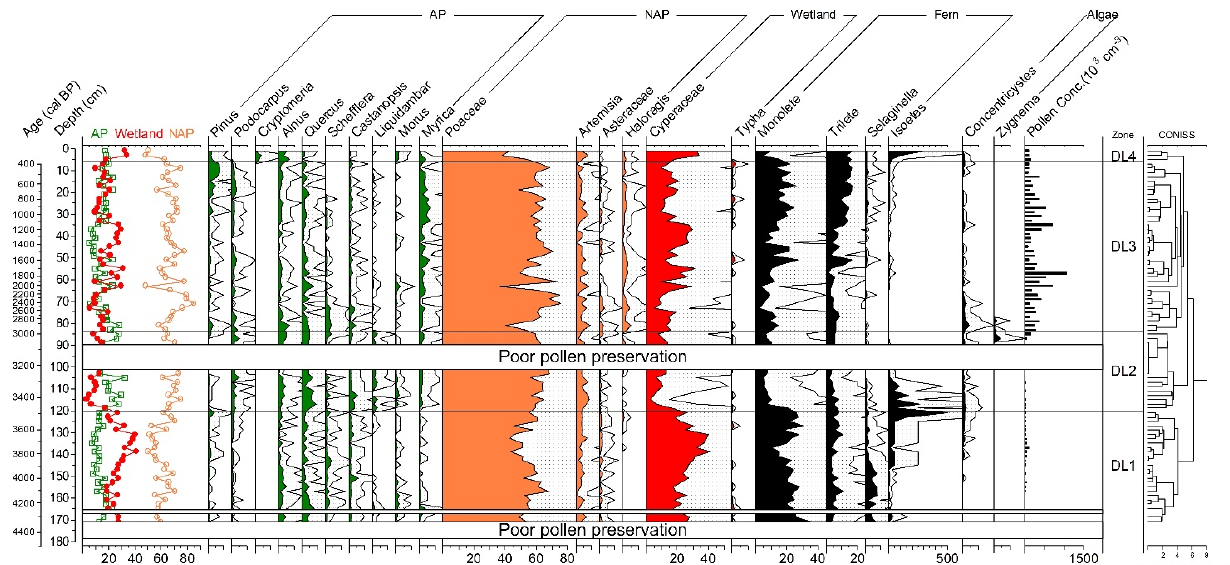
Figure 5. Profile diagram of pollen percentages for selected pollen taxa with respect to the four pollen zones in the Dream Lake sediment core. Only taxa present at >1% in at least three samples are plotted. Percentages are based on the sum of all pollen. The shaded area is a five-fold exaggeration of the original values. Three intervals of poor pollen preservation are represented with blank white bars.